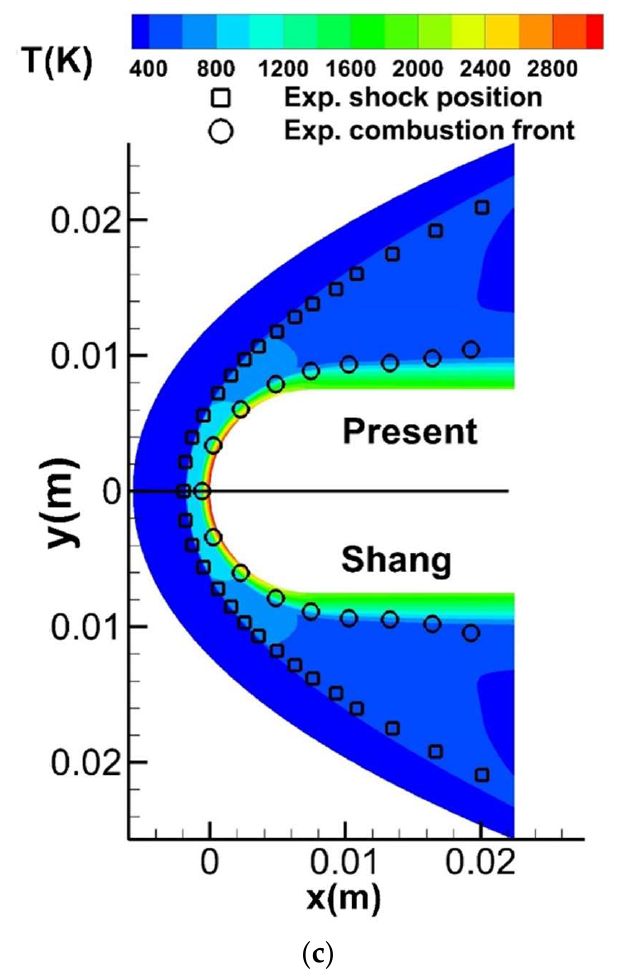
Figure 12. Comparison of the sub-detonative combustion flow fields. ( a ) Density gradient distribution compared with the schlieren image. ( b ) Pressure and temperature distribution of the hybrid kinetic scheme. ( c ) Bow shock wave and combustion front of the numerical results.